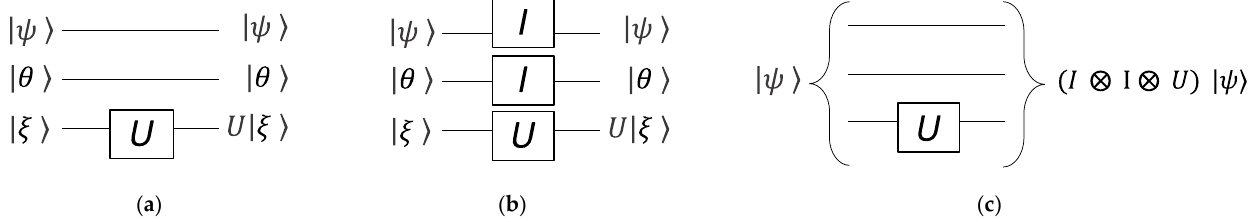
Figure 5. Module with a gate applied to a subset of qubits: ( a ) a single gate to a qubit; ( b ) the equivalence using identity gates; and ( c ) the situation when there is entanglement.